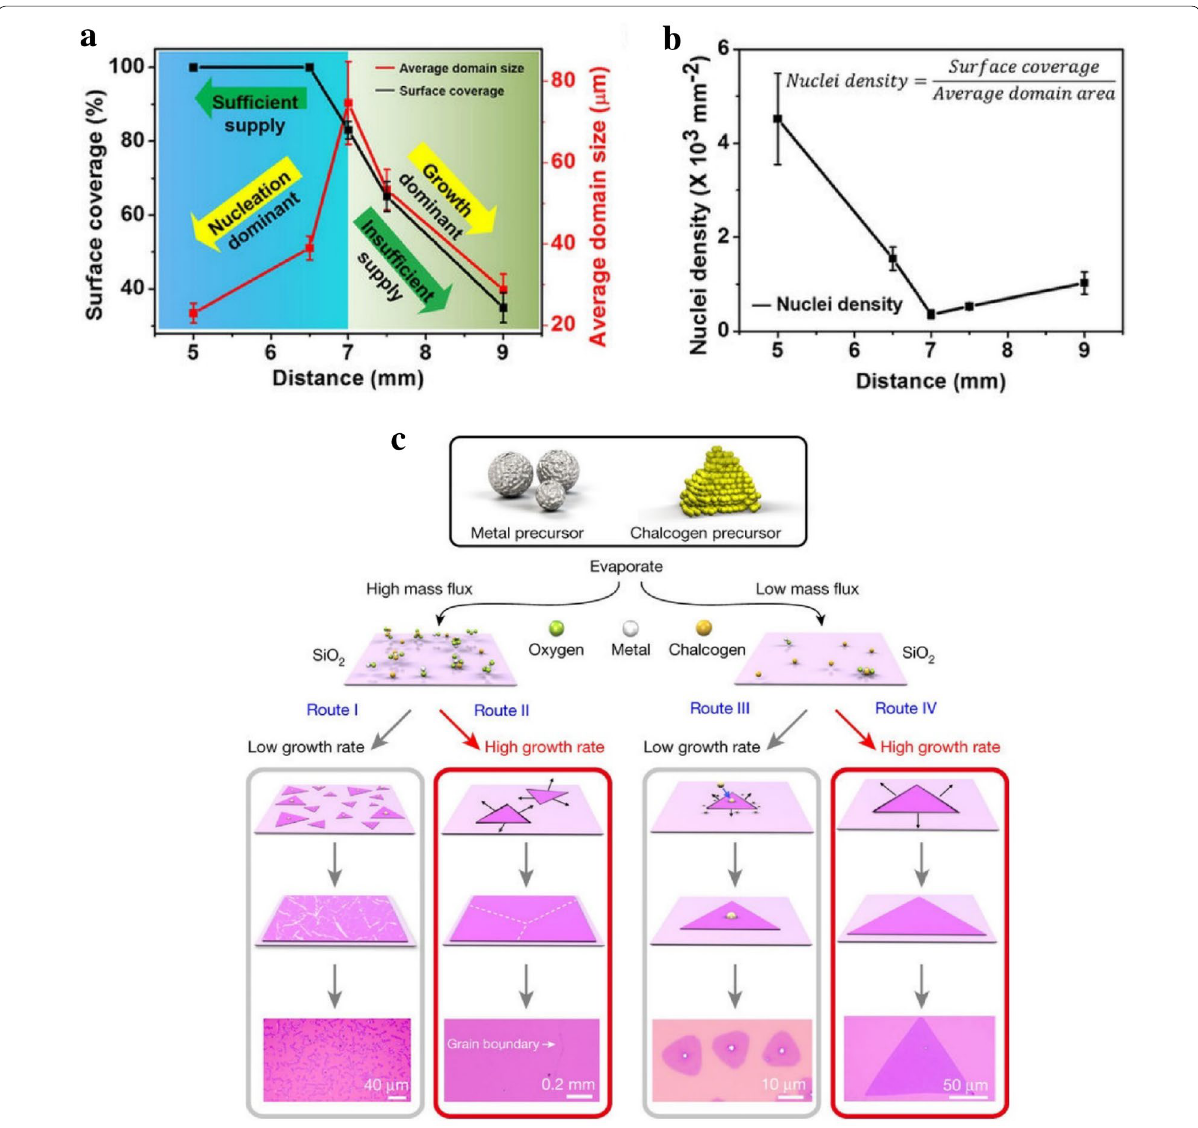
Fig. 3 Grain size and boundaries control. a Surface coverage and average domain size of MoS 2 as a function of precursor/substrate distance, b effect of precursor/substrate distance on the nuclei density of MoS 2 during growth [62], Copyright 2015, Springer Nature. c Flow diagram represents different routes for the synthesis of distinct types TMCs by the chemical vapor deposition method. Different routes indicated the nucleus formation and their growth mechanism as a function of mass flux of precursor and growth rate [52]. Copyright 2018, Springer